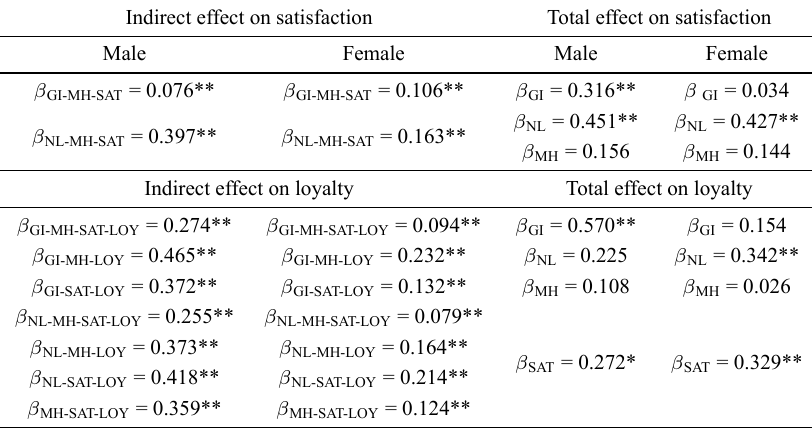
Table 4. The mediating effects of the structural